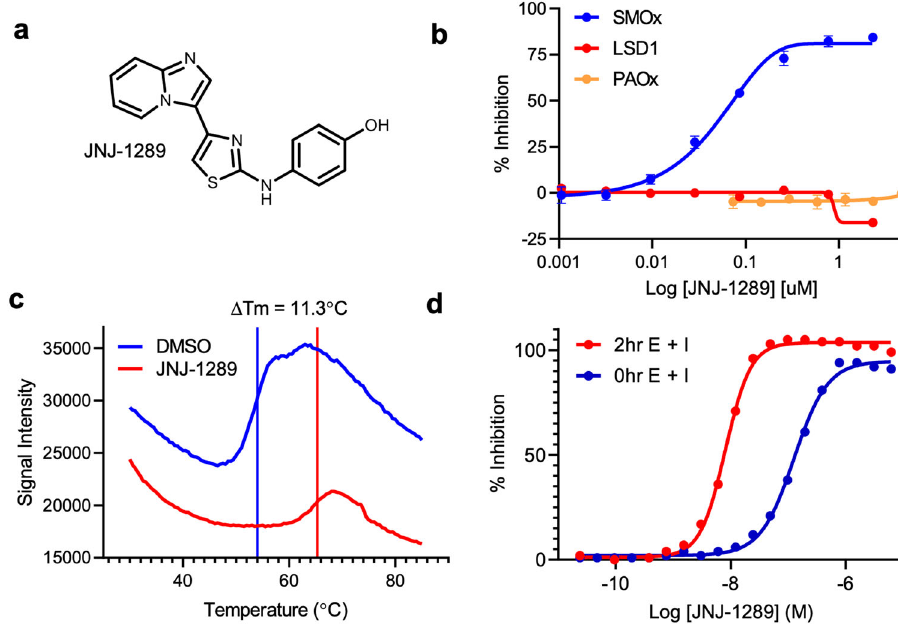
Fig. 5 JNJ-1289 inhibits hSMOX in a time-dependent manner. a Structure of JNJ-1289. b Inhibition by JNJ-1289 at 2.5 nM hSMOX, 60 pM hPAOX or 10 nM LSD1 in the presence of 30 µ M Spm, 20 µ M N-AcSpm, or 8 µ M H3K4me2 peptide, respectively. JNJ-1289 inhibits hSMOX under these assay conditions with an IC 50 value of 50 nM. c Thermal shift analysis of hSMOX reveals that incubation with JNJ-1289 (red line) stabilizes the protein with Δ T = 11.3 °C compared to DMSO control (blue line). d Inhibition of hSMOX measured using a 0 h or 2 h preincubation of enzyme and JNJ-1289 at 2.5 nM m enzyme and 30 µ M Spm. The observed IC 50 values of 127 and 8 nM at 0 and 2 h enzyme-inhibitor preincubation times, respectively, suggested that JNJ- 1289 inhibits hSMOX in a time-dependent